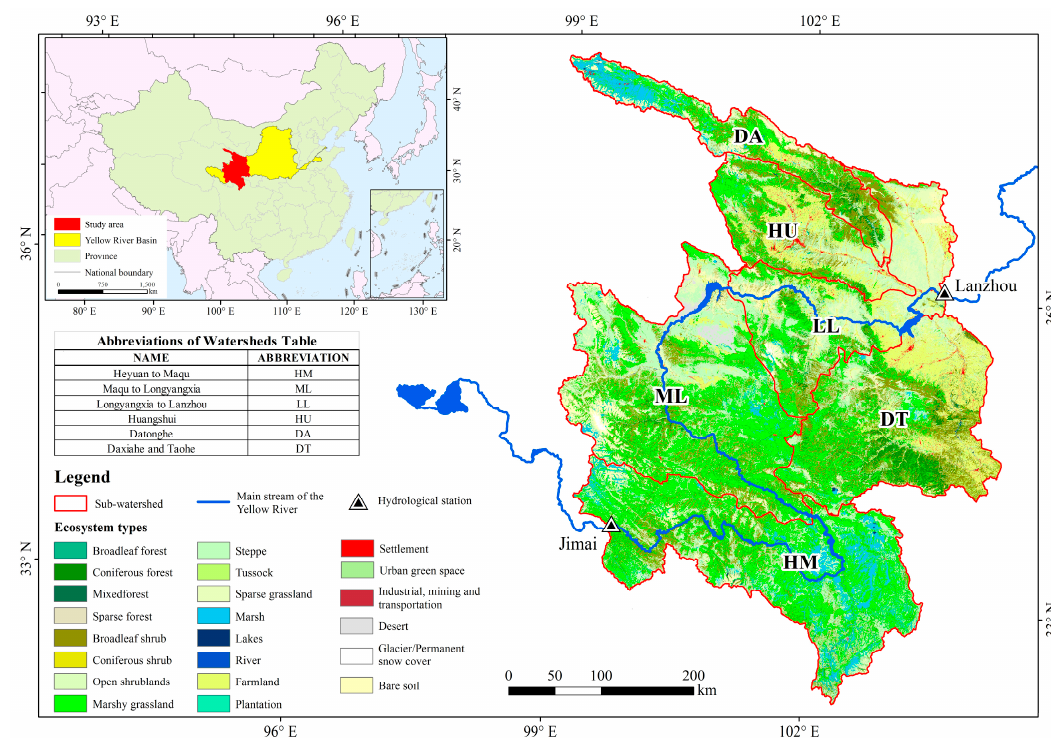
Figure 1. Spatial distribution of the ecosystem in the study area.